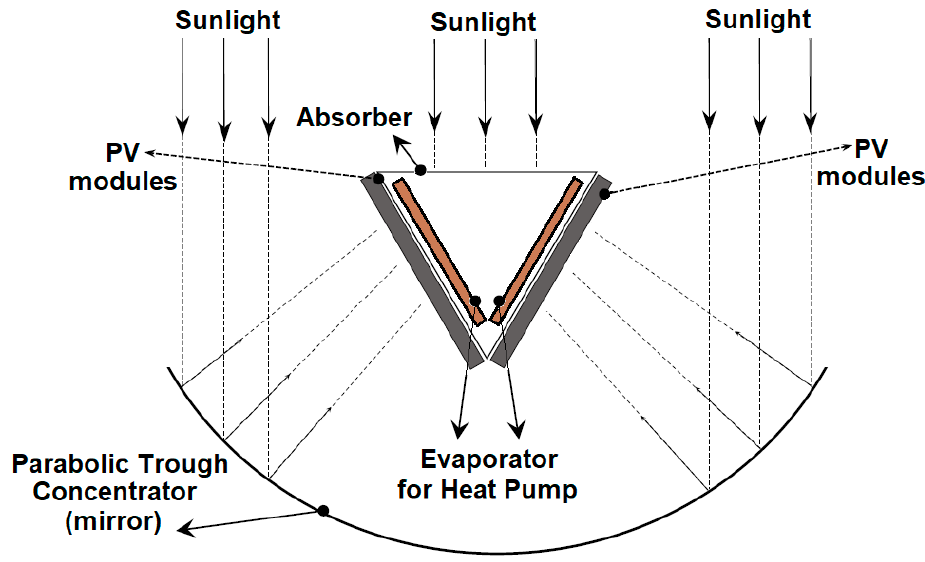
Figure 3. A cross-sectional schematic diagram of the parabolic triangular trough PV collector.